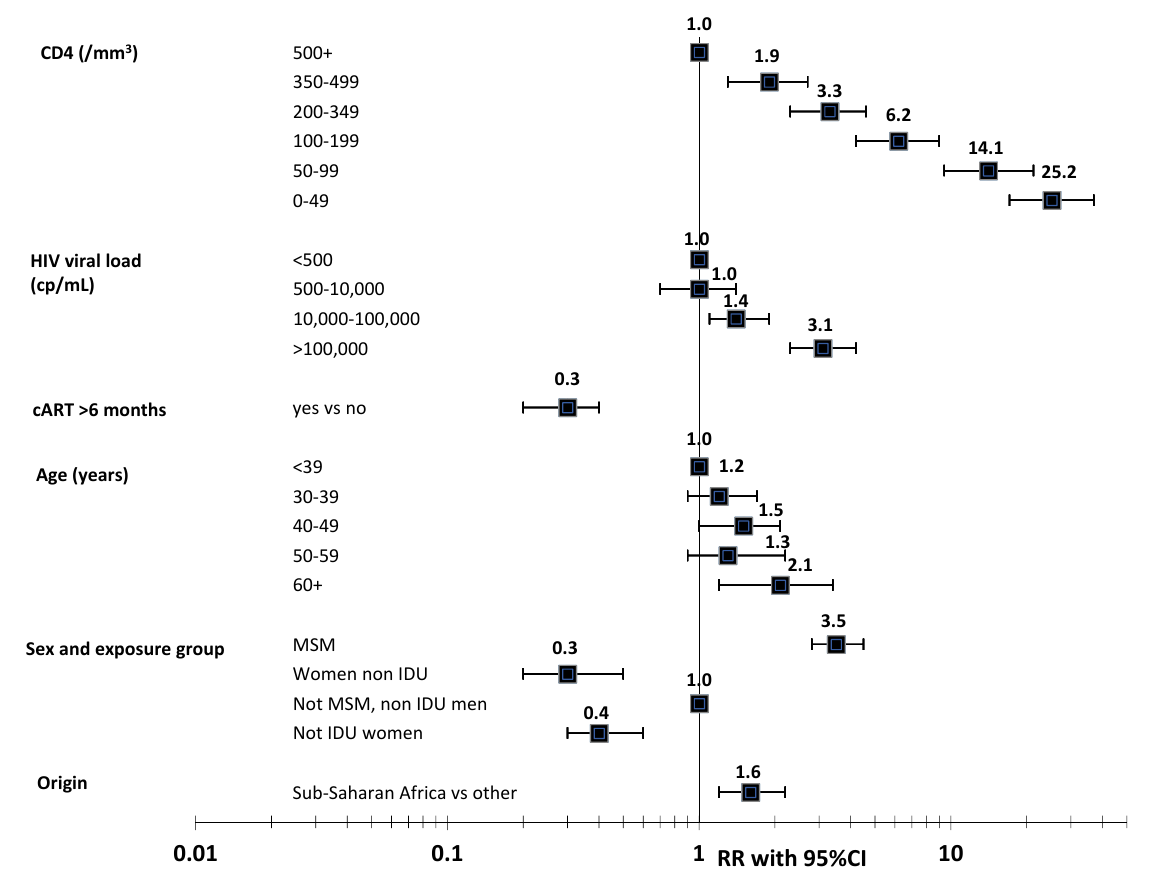
Figure 1. Risk factors of Kaposi’s sarcoma in PLHIV. Adapted from Guiguet et al., Lancet HIV 2009 [21]. Note: RR: relative risk; 95%CI: 95% confidence interval; MSM: men having sex with men; IDU: intravenous drug user. p -values: CD4: p < 10 − 4 , HIV viral load: p < 10 − 4 , exposure to cART: p < 10 − 4 , age: p = 0.04, sex and exposure group: p < 0.0001, origin: p = 0.008.